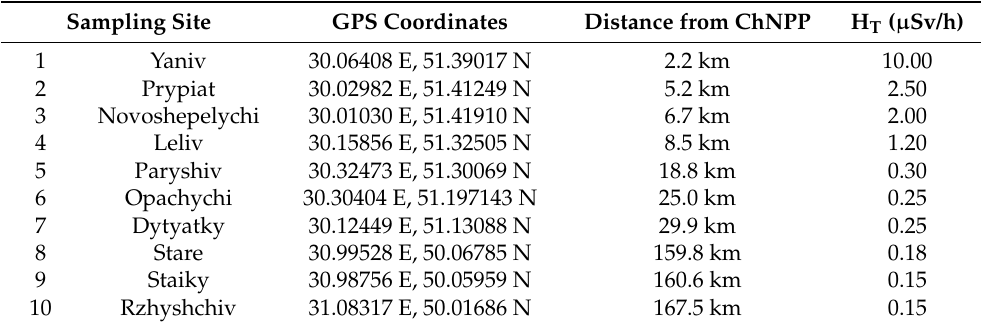
Table 1. Fungi sampling sites within the Chornobyl exclusion zone (No. 1–7) and Kyiv region (No.